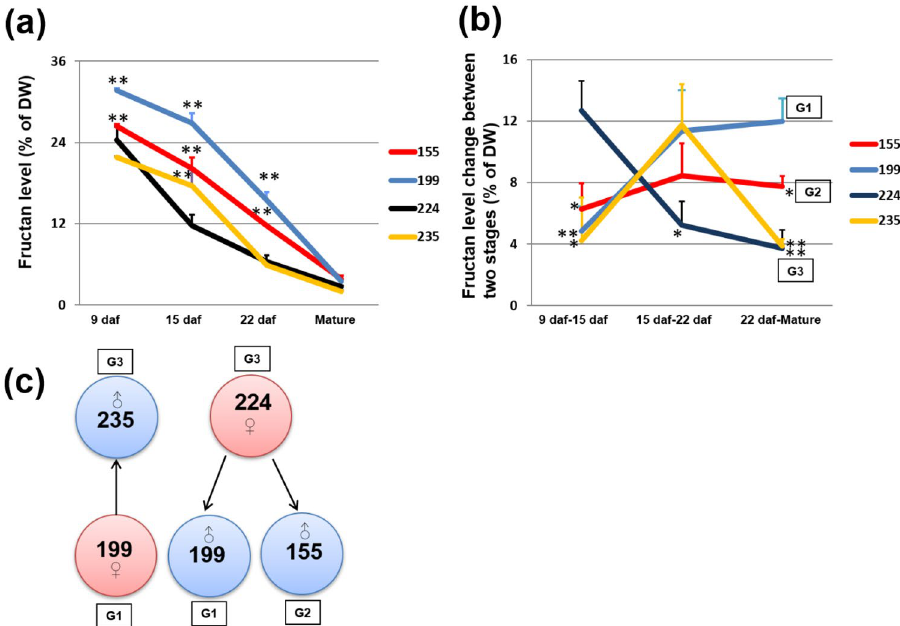
Figure 1. Design of the crossing strategy. ( a ) Fructan percentage per unit dry weight (DW) during grain development at 9, 15, 22 days after flowering (daf) and at grain maturity for 4 among the 12 barley lines (see Supplementary Table S1 and Supplementary Fig. S1). ( b ) Percentage change in fructan level between two development stages. Groups 1 (G1), 2 (G2) and 3 (G 3) are indicated by boxes. ( c ) Details of the crossing strategy. Pink color indicates maternal and blue color indicates paternal, arrows indicate two crossed varieties. Student’s t-test was used (Error bars show SD). * P < 0.05 and ** P < 0.01 are shown for significant differences between the sample level and the lowest sample level at different stages in ( a ). * P < 0.05 and ** P < 0.01 in ( b ) are shown for significant differences between the fructan reduction level of two stages and the highest reduction level. Three biological replicates or grains from three independent plants ( n = 3) were used for